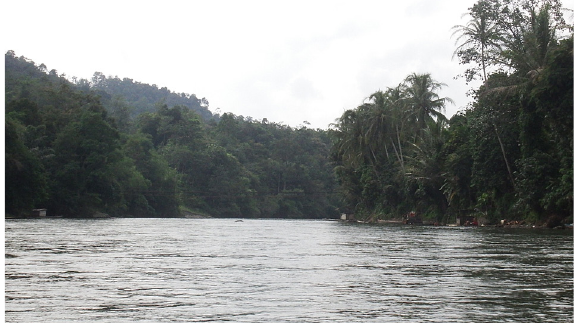
Figure 2. Muara Kulam River (Musi basin, South Sumatra), showing the location where Crossocheilus obscurus was collected. Photo- graph by M.